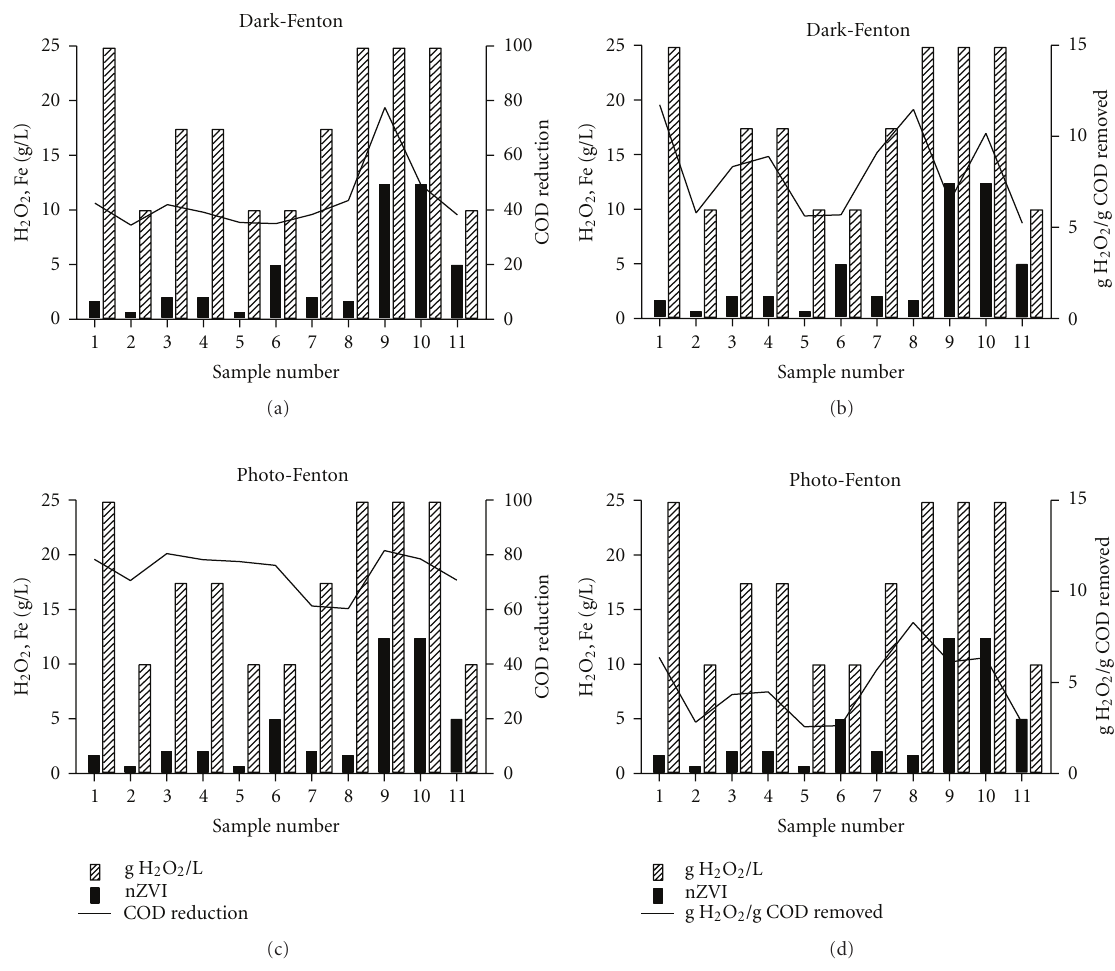
Figure 2: Results from dark-Fenton (a) and (b) and photo-Fenton (c) and (d) experiments using nZVI in 11 runs each. (a) and (c) Amounts of reagents (g/L) and COD removal (%); (b) and (d) amounts of reagents (g/L) and g H 2 O 2 consumed per g COD